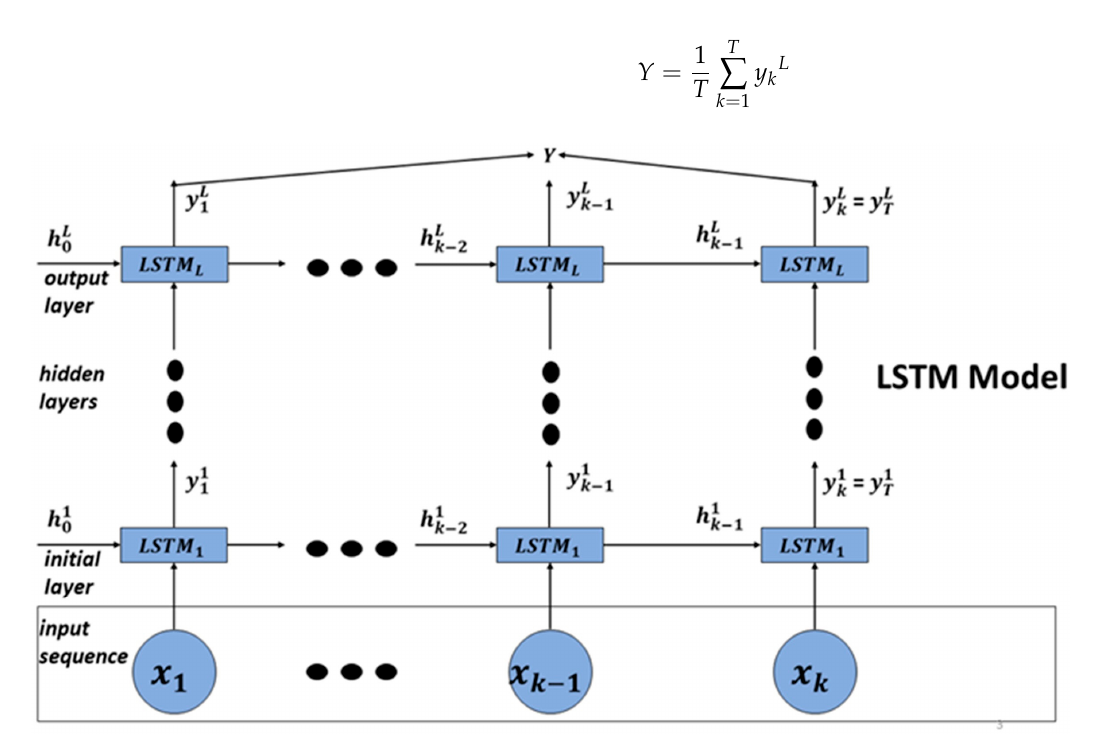
Figure 5. LSTM model basic visualization.